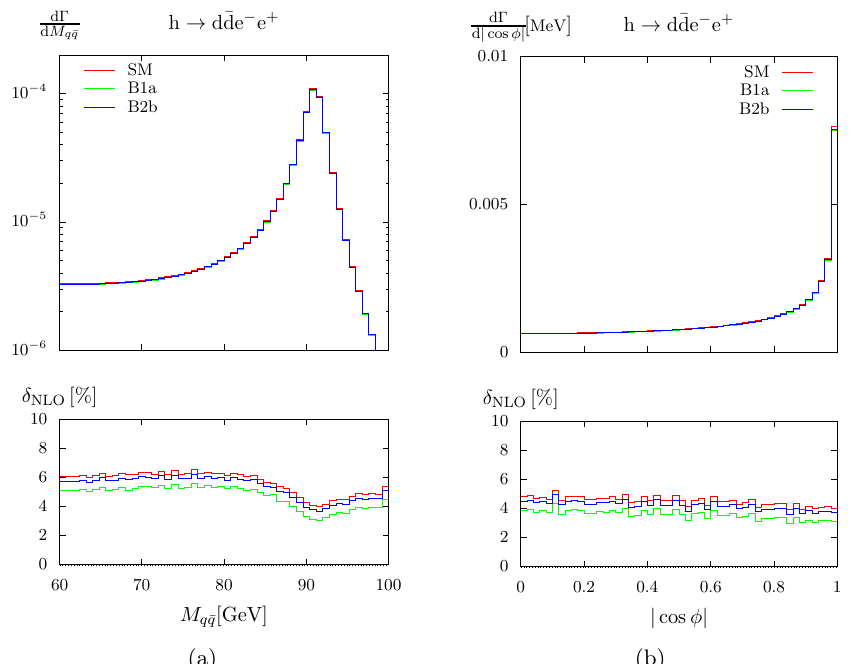
Figure 38 . Invariant-mass (a) and angular distributions (b) of the charged-current semi-leptonic d(cid:22)de (cid:0) e + for the SM and the THDM scenarios B1a and B2b. The relative NLO corrections decay h ! to the distributions are plotted in the lower panels.